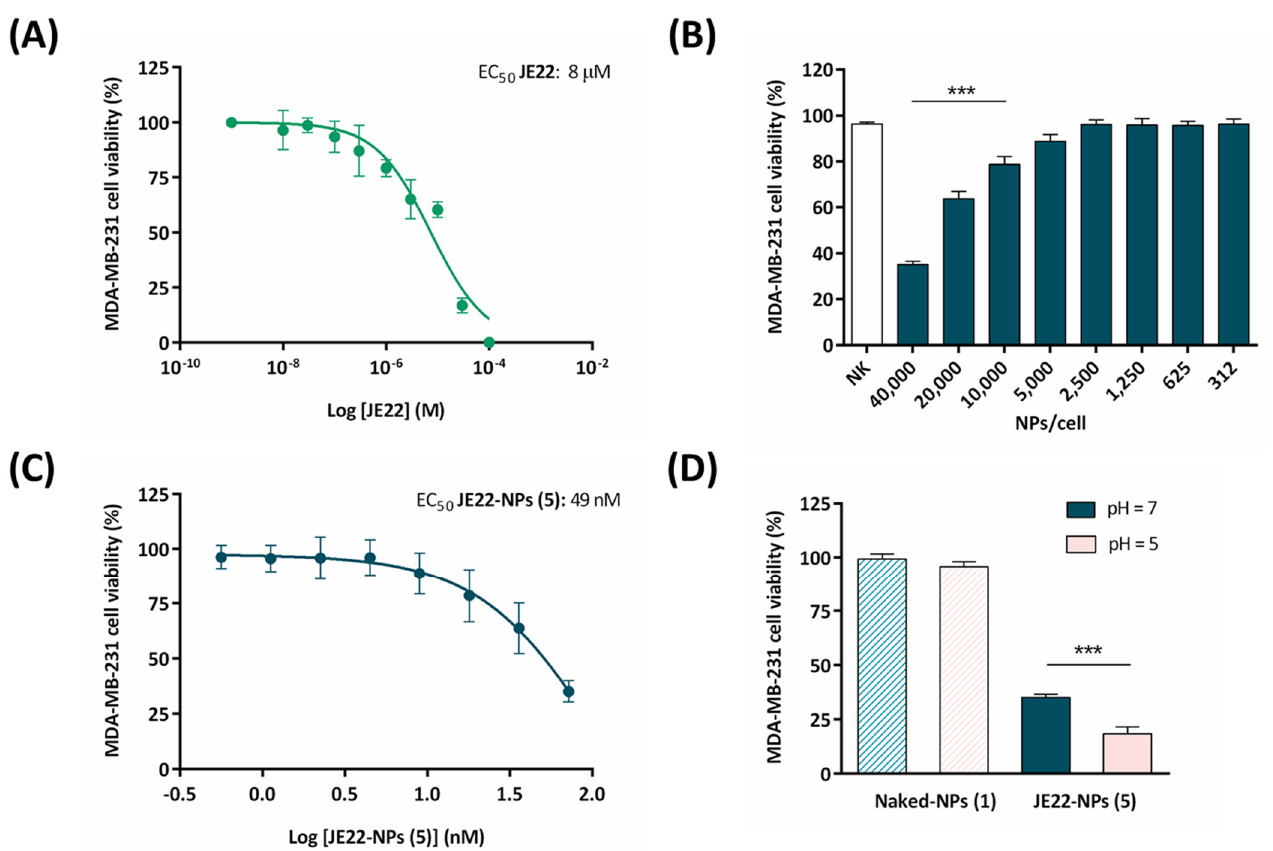
Figure 5. Evaluation of cell viability of the designed nanodevice ( JE22-NP, 5 ) ( A ) Dose–response curves for JE22 against MDA-MB-231 cells after 5 days of treatment. Error bars: ± SD from n = 3. ( B ) Bar graph showing the effect of JE22-NPs ( 5 ) on cell viability of MDA-MB-231 cell line. A